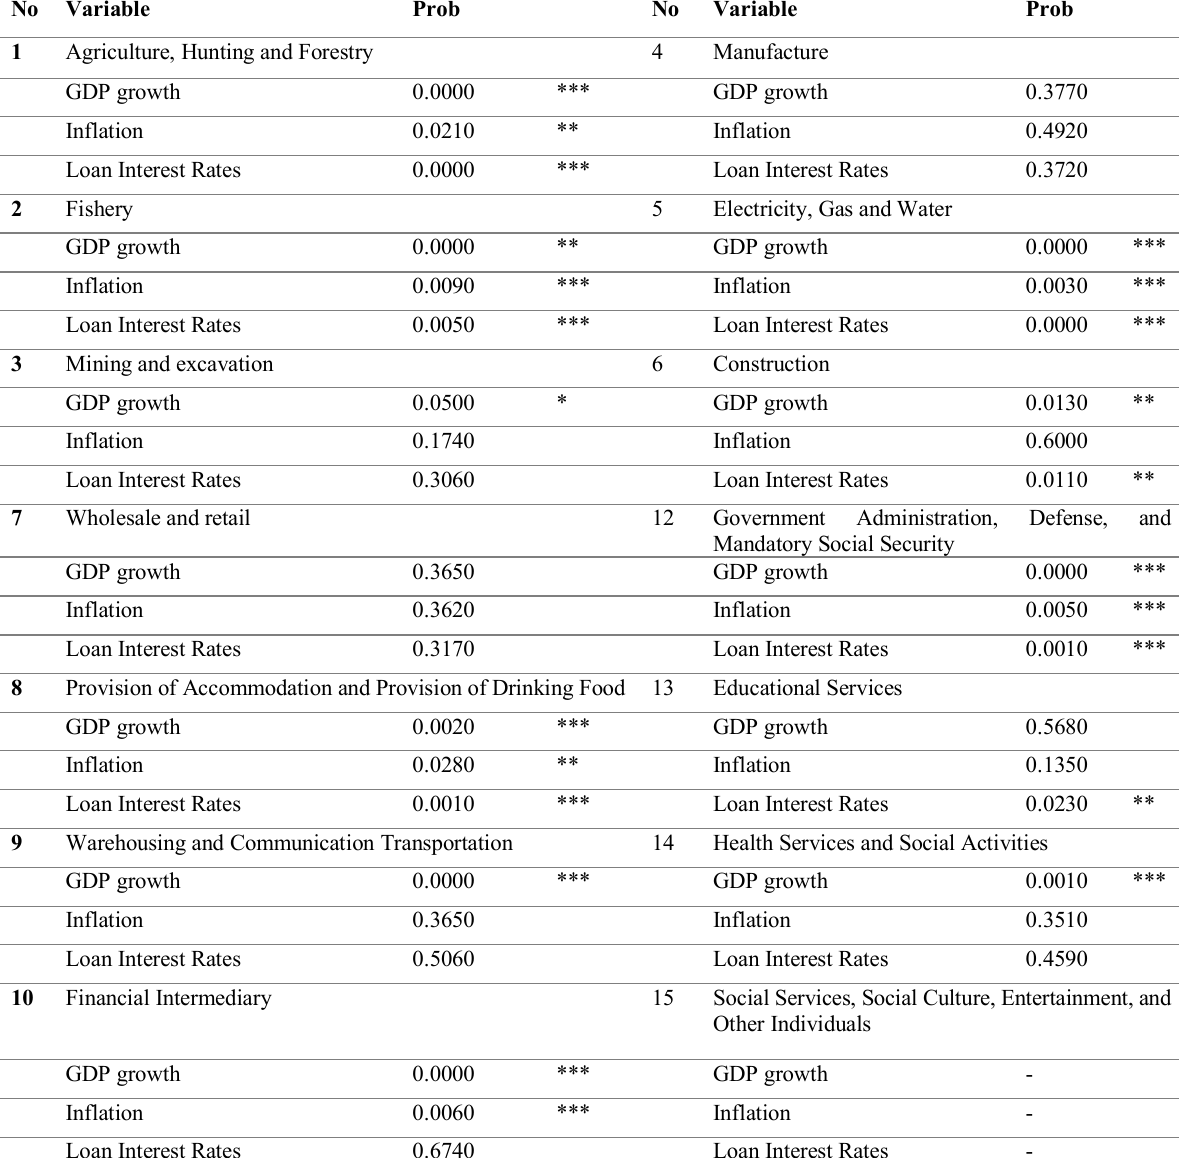
Table 3 : Level of Significance of Variables in the Long-Term